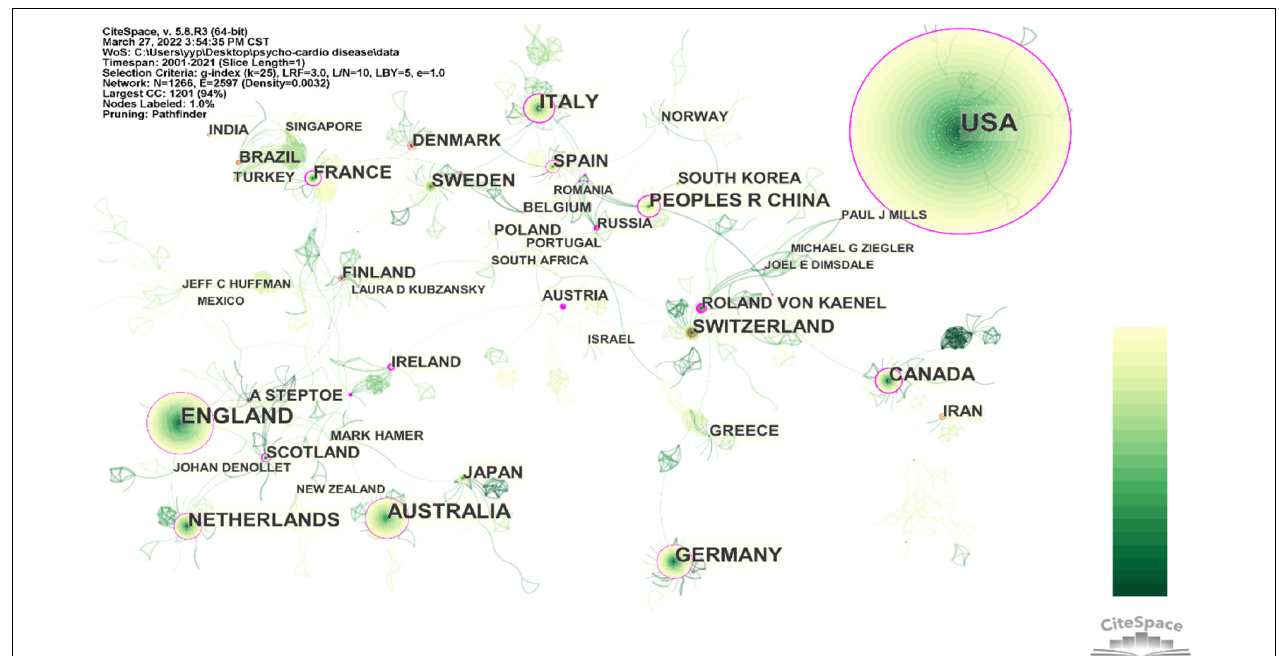
FIGURE 2 | Countries–authors hybrid network of publications about the psycho-cardiological disease and related literature.